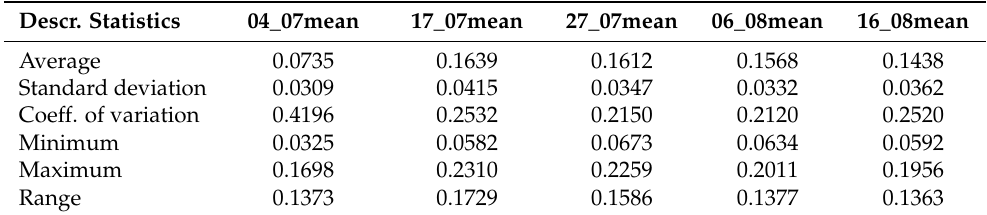
Table 12. The descriptive statistics of the PVI mean values across all pilot fields during each data collection date.